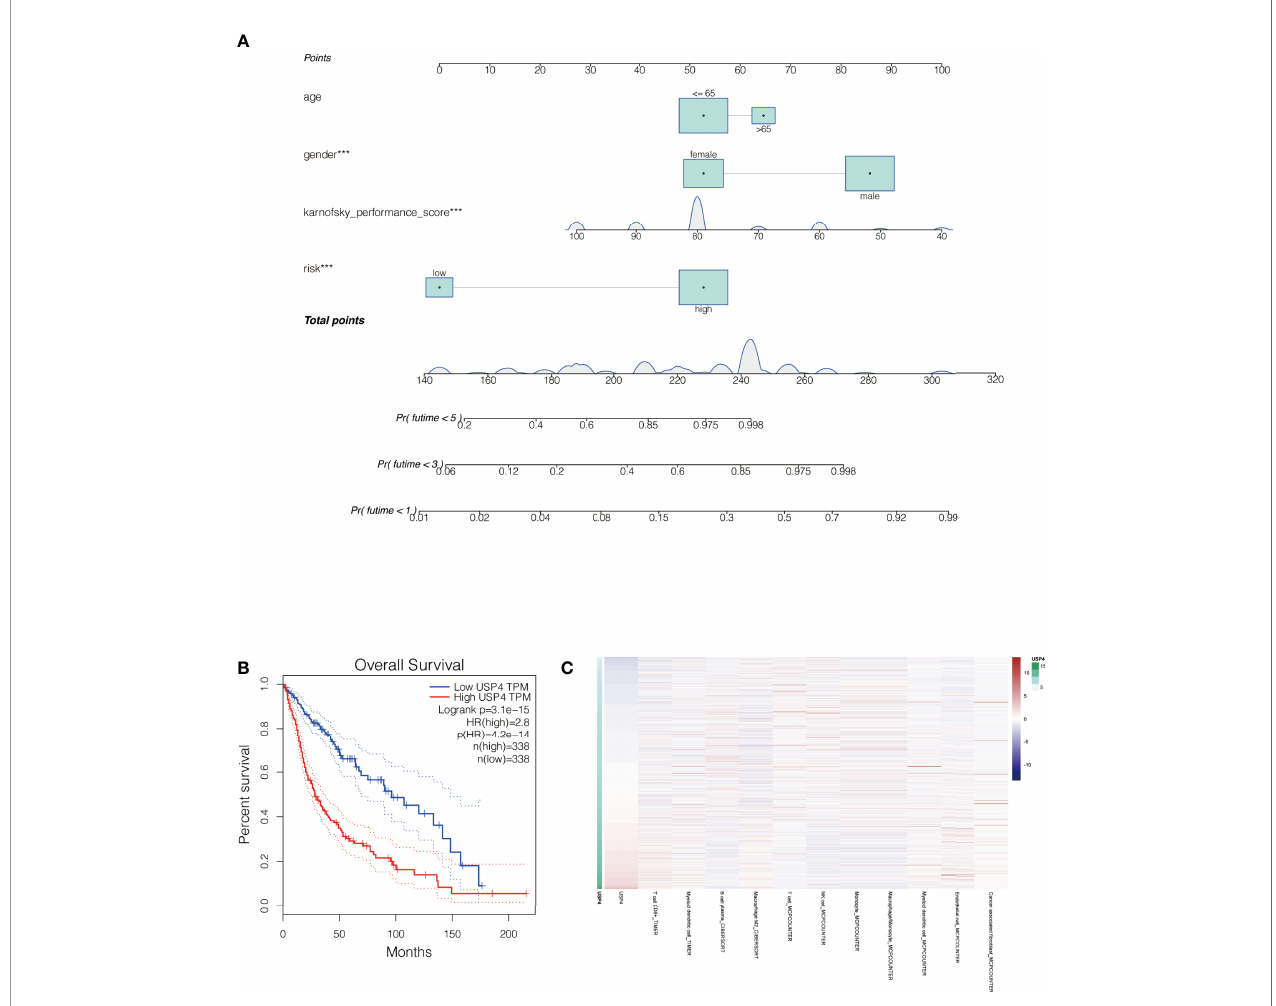
FIGURE 10 | Nomogram of the signature and the analysis of the key gene USP4 in gliomas. (A) A nomogram was created to evaluate the prognosis of glioma patients at 1, 3, and 5 years. (B) Survival analysis of USP4 in GEPIA database. High expression of USP4 is associated with poor prognosis of gliomas. (C) Immune correlation analysis of USP4 in glioma.